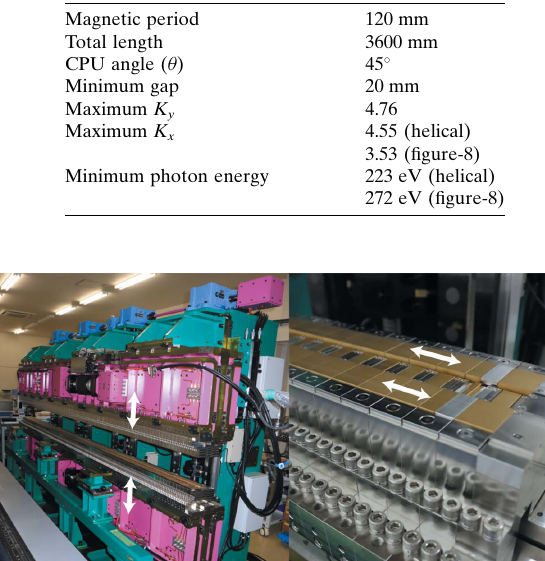
Table 1 Specifications of HEU120 installed at SPring-8 BL17SU.